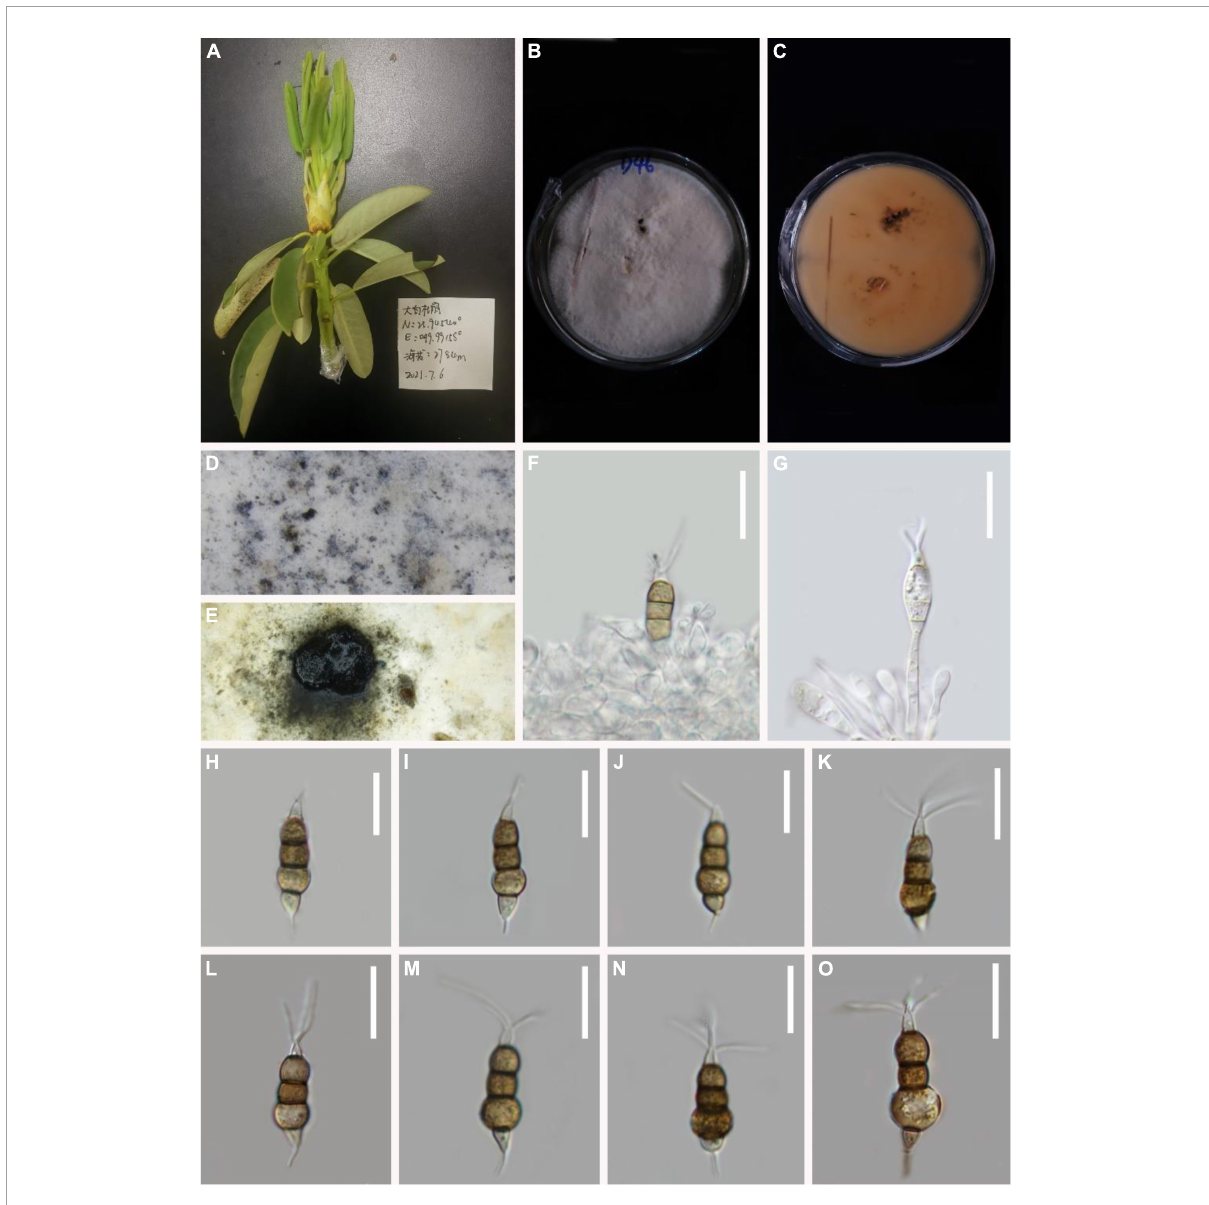
FIGURE6 Pestalotiopsis rosarioides (KUN-HKAS 124574, holotype). (A) Leaves of Rhododendron decorum . (B,C) Culture on potato dextrose agar (PDA) (upper and lower view). (D,E) Conidiomata on PDA. (F,G) Conidiophores, conidiogenous cells, and conidia. (H–O) Conidia. Scale bars: (F–O) 15 µ